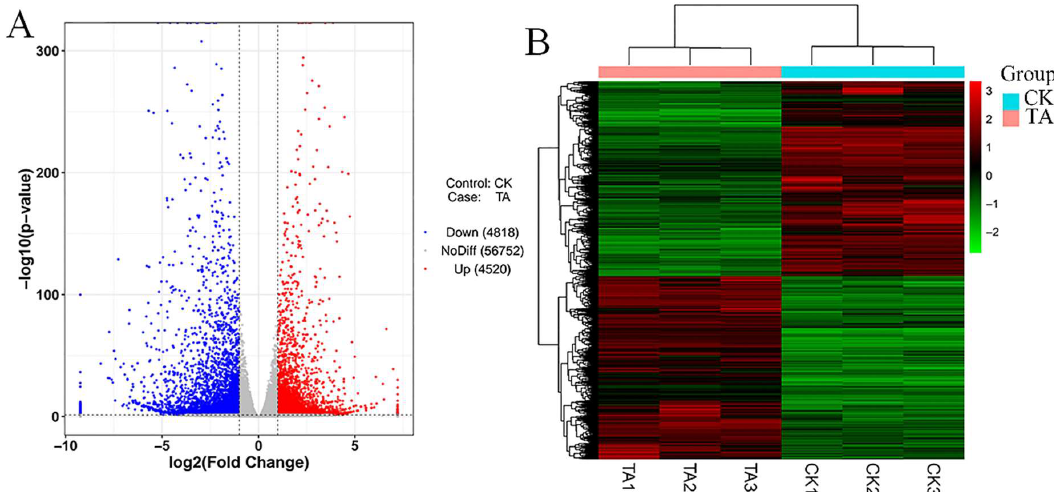
Figure 5. Classification analysis of di ff erentially expressed genes. ( A ). Volcano map displayed the relation between log 2 (Fold Change) and -log 10 ( p -value), which more obviously showed the diversity expression of up-regulated and down-regulated DEGs (di ff erentially expressed genes). The blue color on the figure were down-regulated genes, the red were up-regulated genes and the grey color in the middle were the genes have no di ff erence. ( B ). Clusters of di ff erentially expressed genes in the control and TA-treated groups. Genes were shown horizontally, and each column was a sample. The red was highly expressed genes and green was low expressed genes.